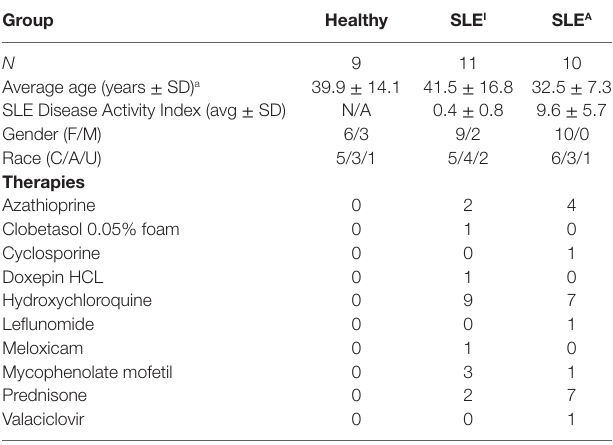
TaBle 1 | Donor demographics.